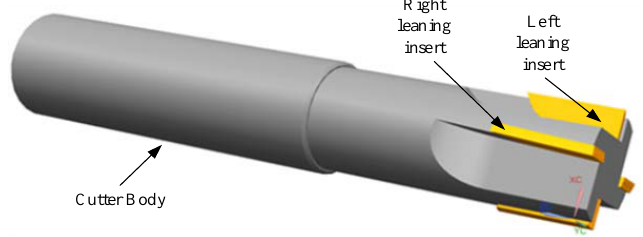
Figure 1. Structure of the staggered PCD end mill.